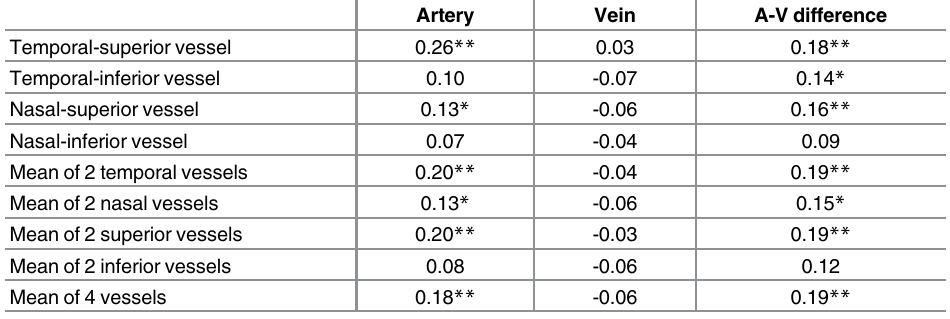
Table 5. Association between Age and Oxygen Saturation in Major Retinal Vessels Measured by Oxy- map T1.